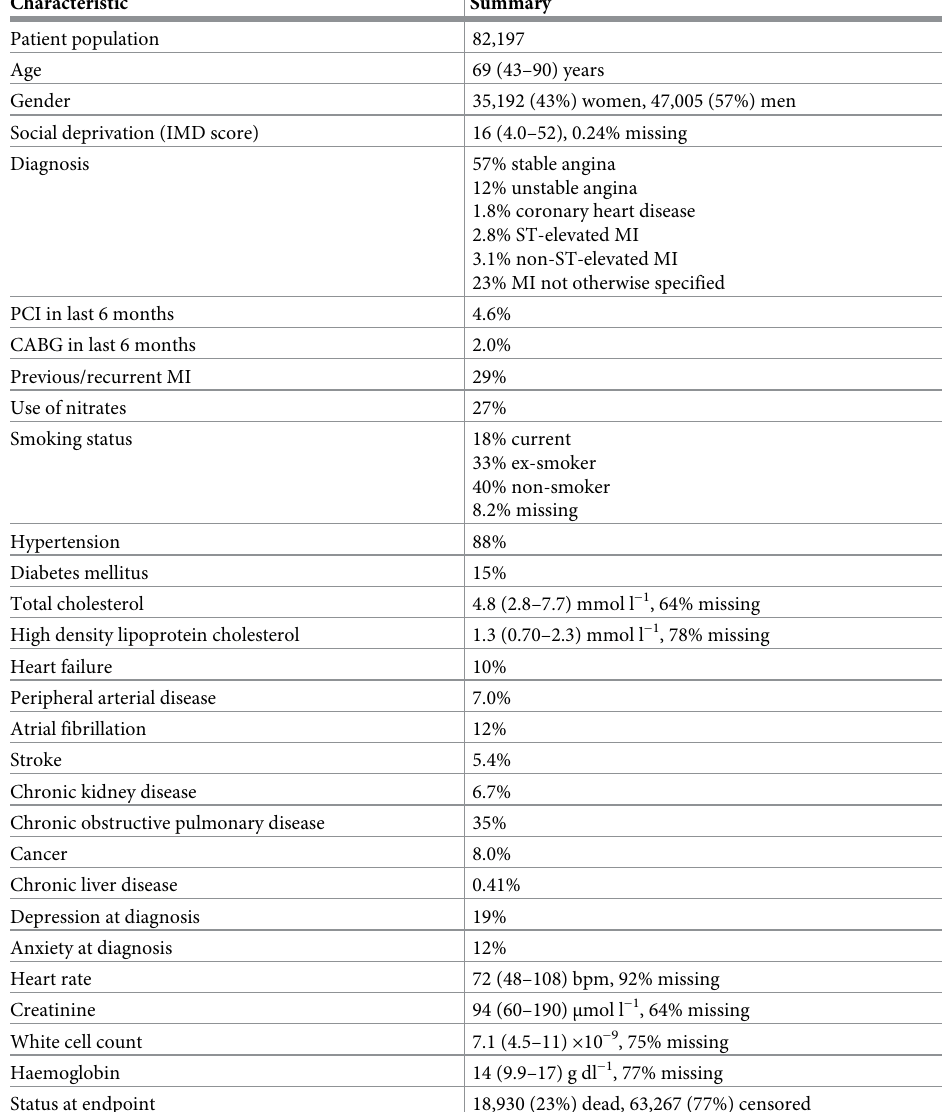
Table 2. Cohort summary, including all expert-selected